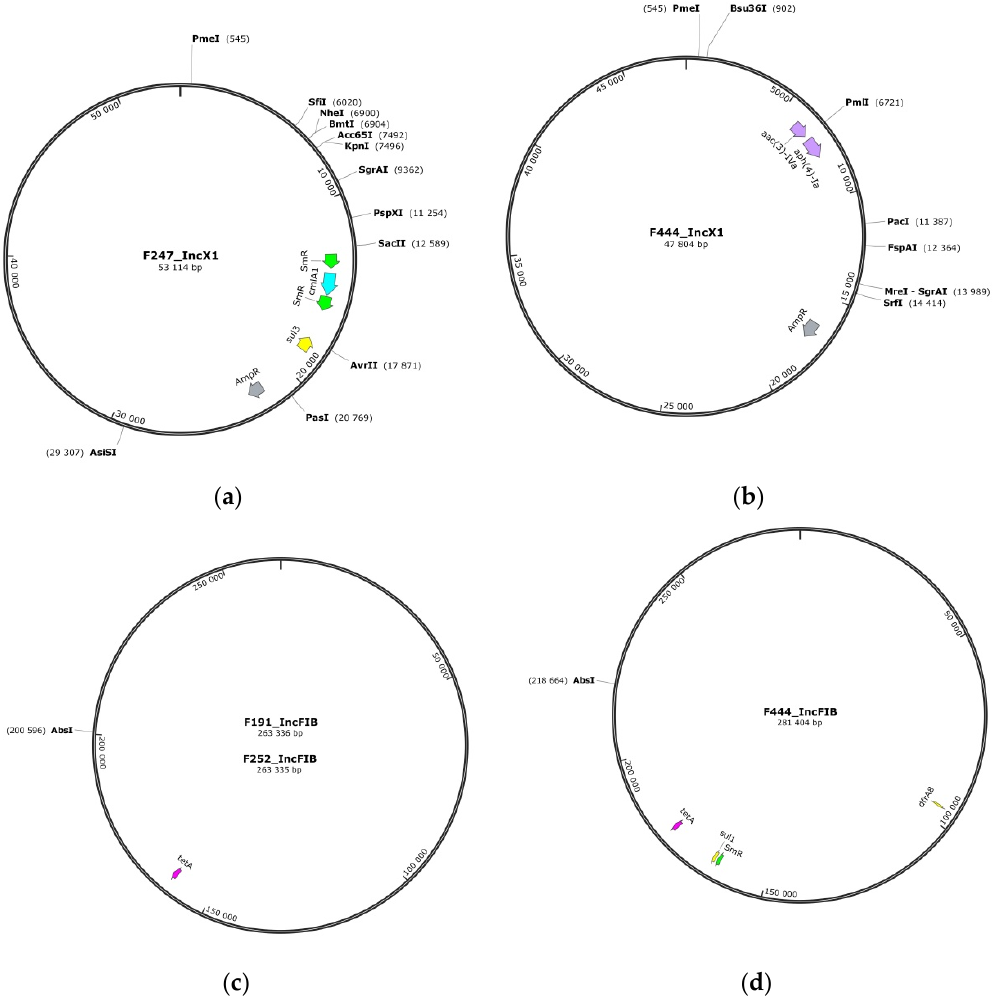
Figure 3. Plasmid replicons IncX1 and IncFIB determined by hybrid assembly. ( a ) Small IncX1plasmid (53 kb) harbored by Crie-F247 S . Infantis isolate. ( b ) IncX1plasmid (47 kb) located in Crie-F444 S . Infantis isolate. ( c ) IncFIB plasmid (263 kb) harbored by Crie-F191 and Crie-F252. ( d ) IncFIB plasmid (281 kb) from Crie-F444. Resistance to doxycycline and tetracycline is highlighted with pink color, resistance to SXT—with yellow, resistance to streptomycin—with green, chloramphenicol AMR genes are shown in blue, ampicillin resistance—in gray, and AMR to aminoglycosides is highlighted with purple. The plasmids were visualized via SnapGene, annotation was performed manually.